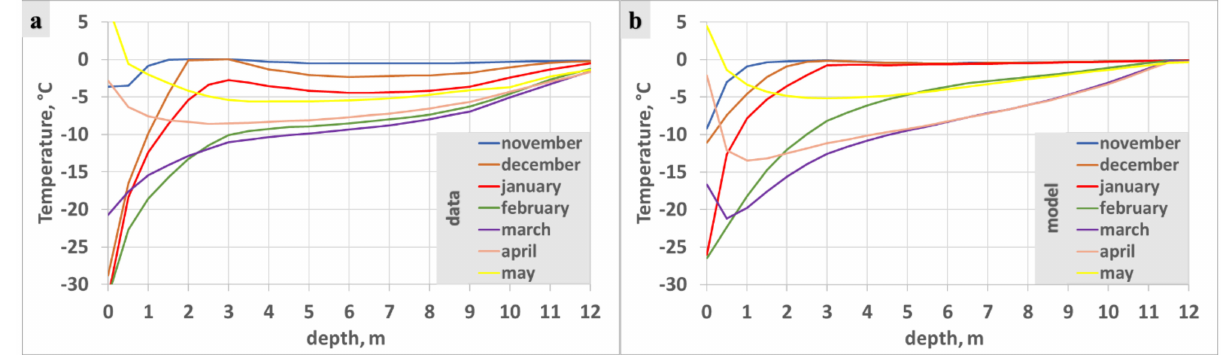
Figure 17. Dynamics of temperature change in well 44–1 in 2021 obtained from temperatures measured using temperature sensors ( a ) and numerical calculations ( b ).